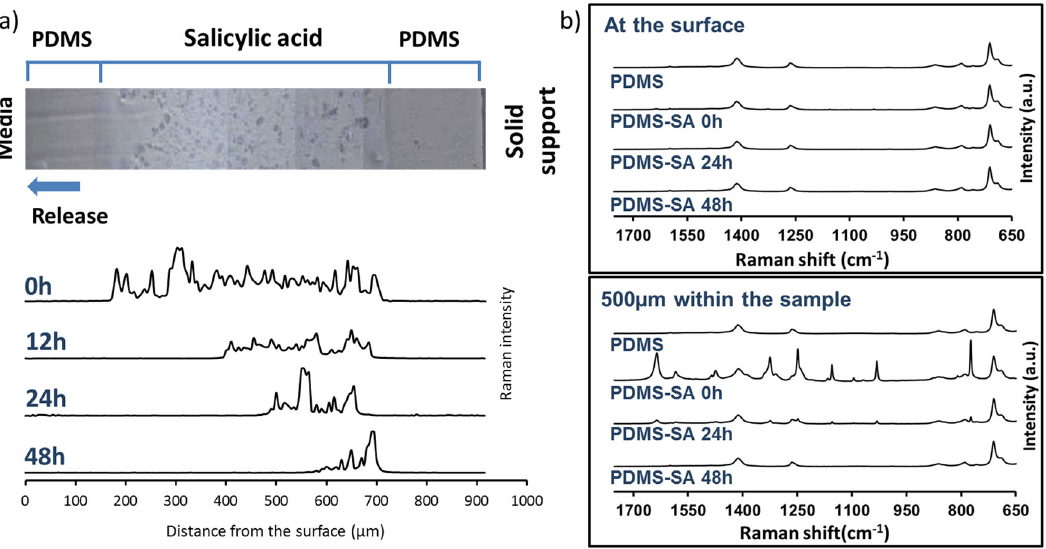
Fig. 5 Raman characterisation of PDMS-SA surface and bulk after SA release at different time points. a SA distribution along the cross section of PDMS-SA as a function of release time probed by confocal Raman microscopy. b Comparison of time evolution for the Raman spectra at the surface and at 500 µm within the